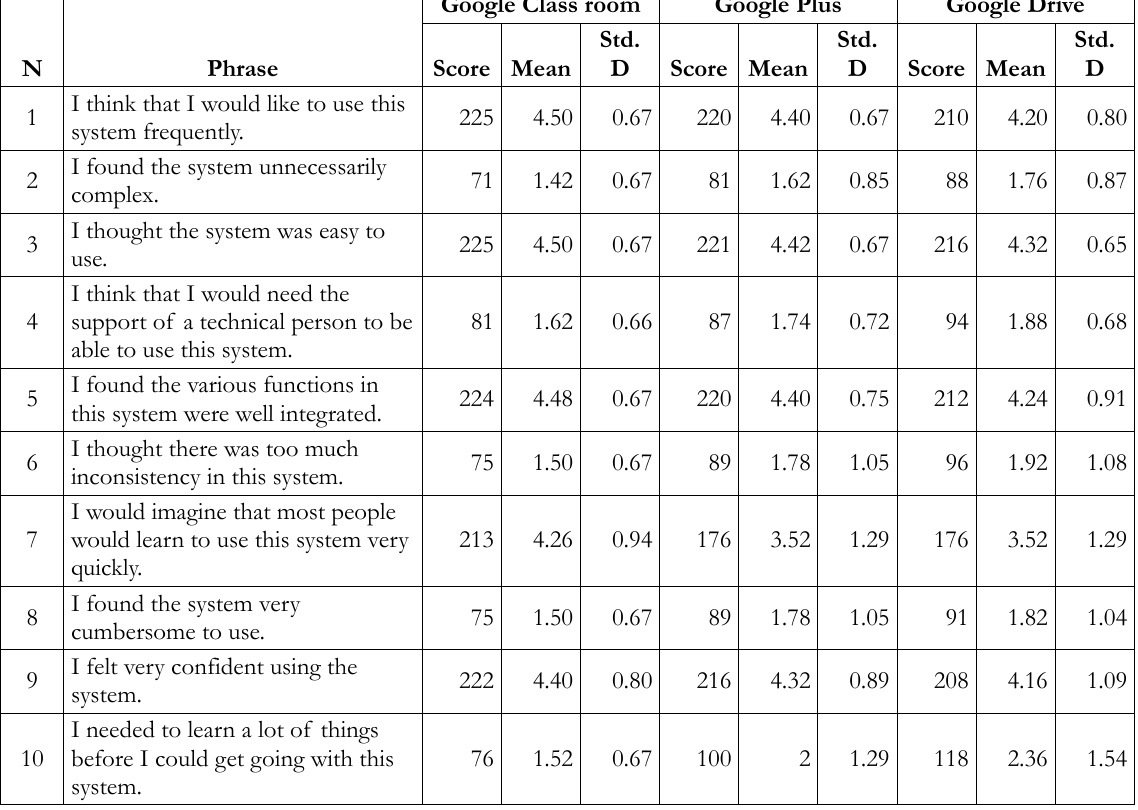
Table 3. SUS results based of the scale of by Brooke (1996)